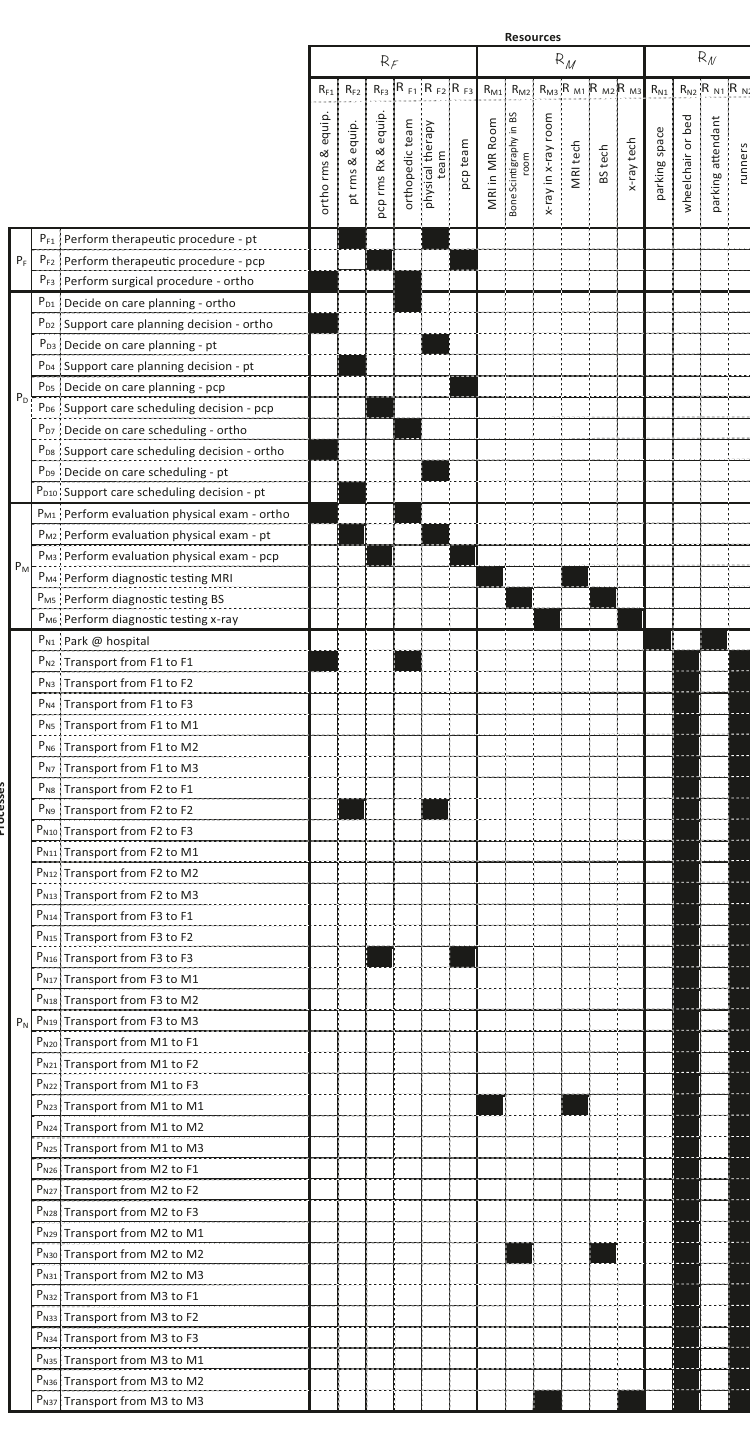
Figure 11: Healthcare delivery system knowledge base 𝐽 𝑆 with allocated processes to resources (dark filled) for the chronic diabetes example.